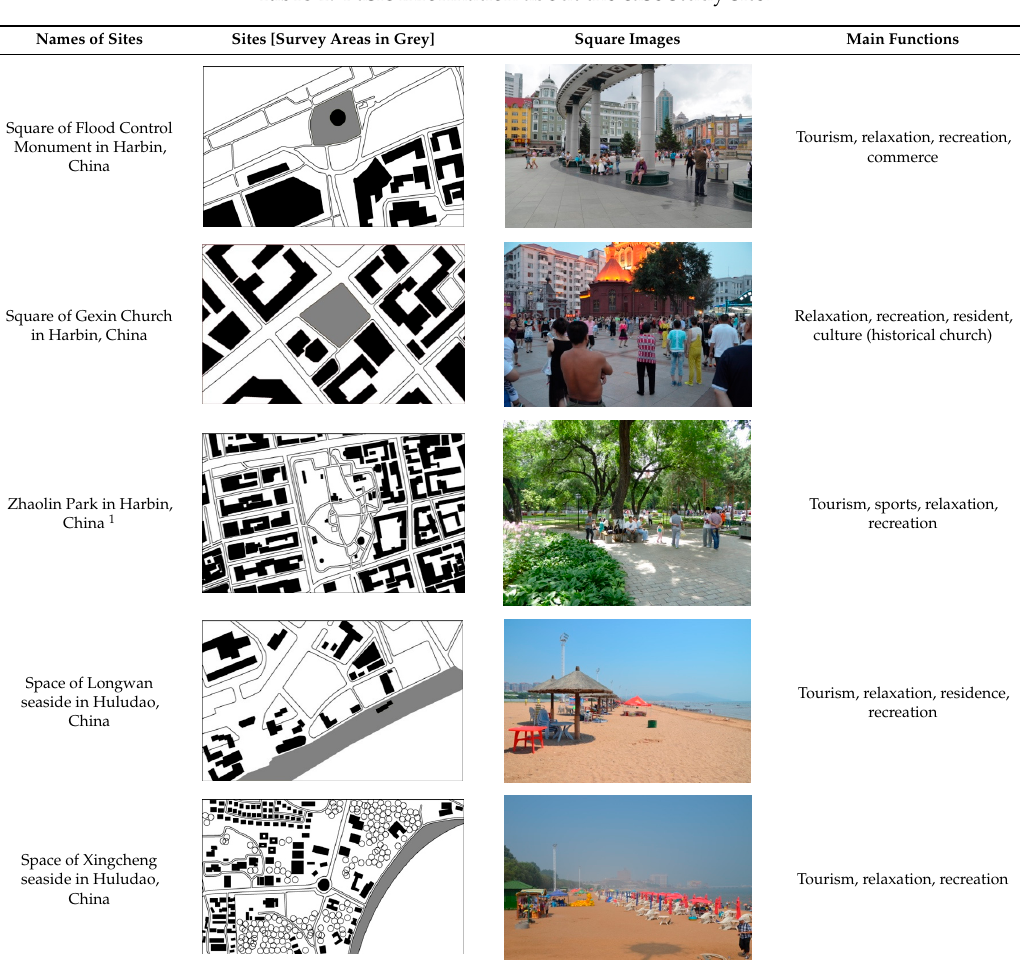
Table 1. Basic information about the case study site.